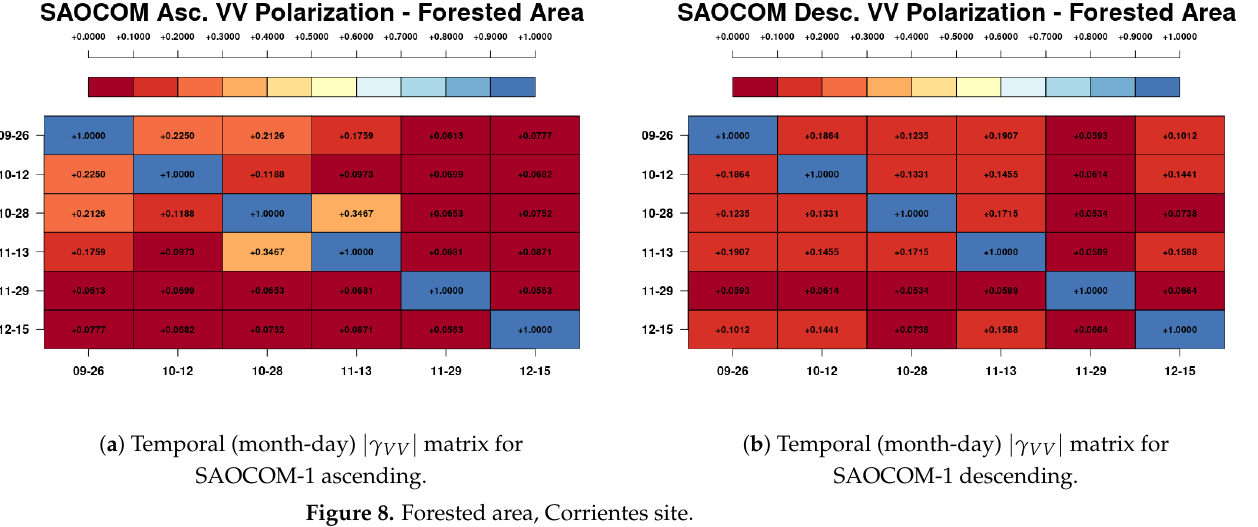
Figure 8. Forested area, Corrientes